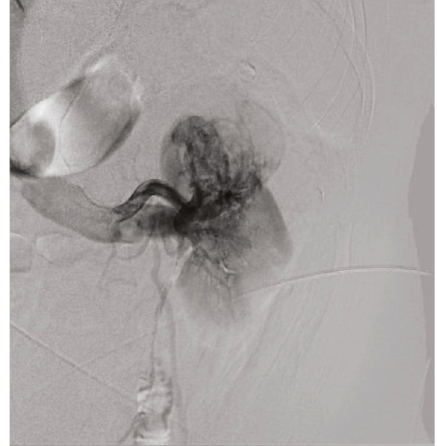
Figure 3: Selective angiography of main renal artery showing early fi lling of enlarged left renal vein with arterialized fl ow within the renal vein.